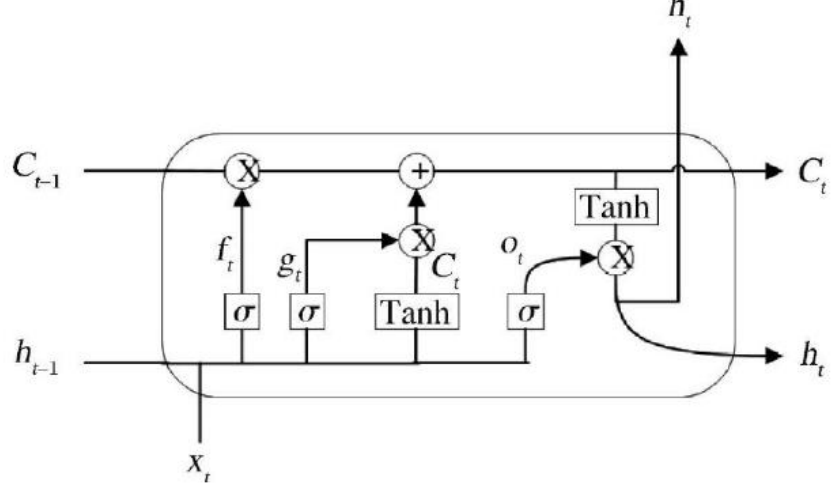
Figure 1. Study area of South Asia and China.